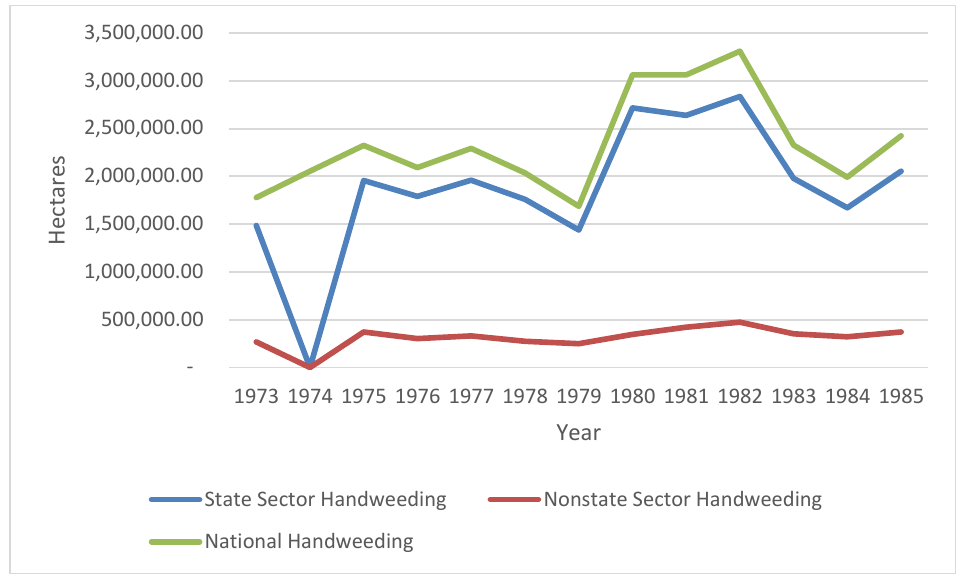
Figure 3. Hand Weeding on National, State and Non-State